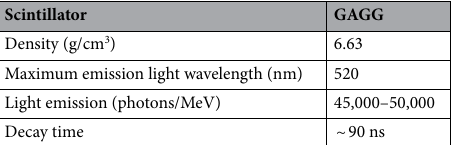
Table 1. Main properties of scintillator plates used for imaging experiments.